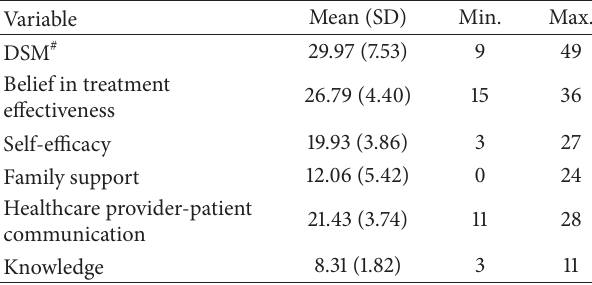
Table 2: Mean and standard deviation of the DSM and factors that may influence DSM behaviours ( 𝑛 = 400